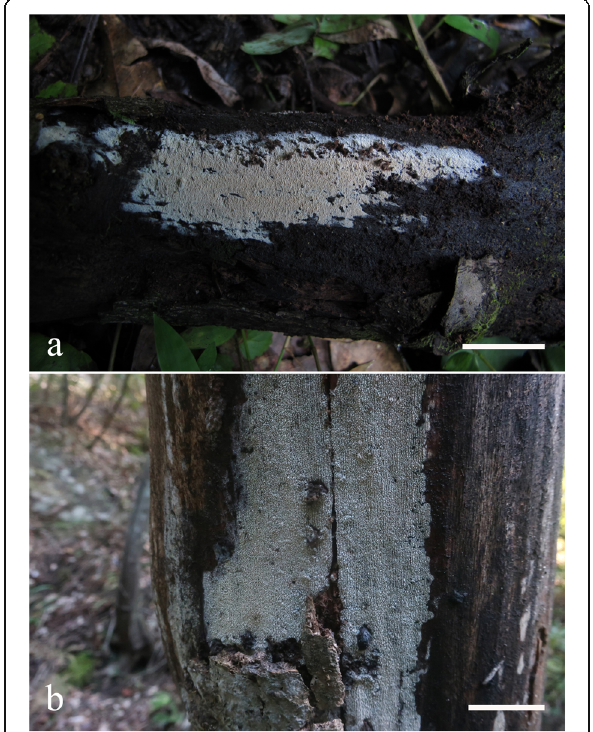
Fig. 15 Basidiomes of Skvortzovia pinicola in situ. a LWZ 20180921-6. b LWZ 20201011-18. Scale bars = 2